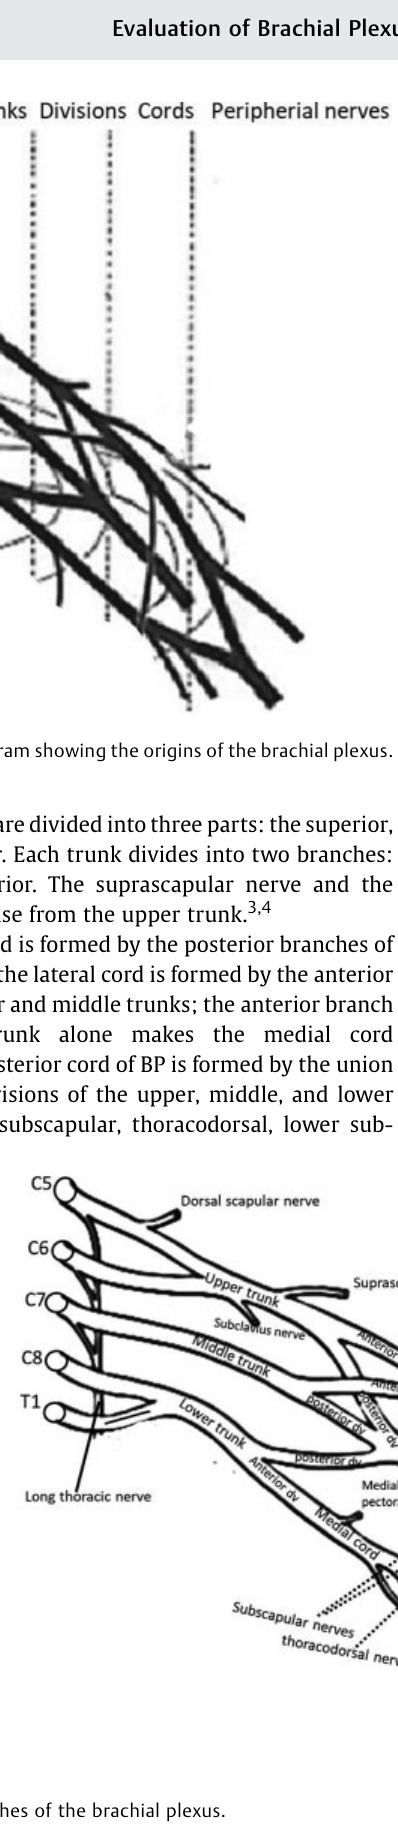
Fig. 2 Terminal branches of the brachial